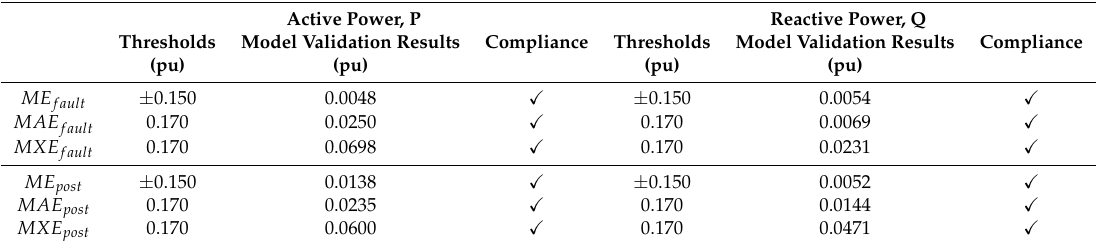
Table 4. Verification of the NTS and TG 4 validation criteria applied to the generic WT simulation